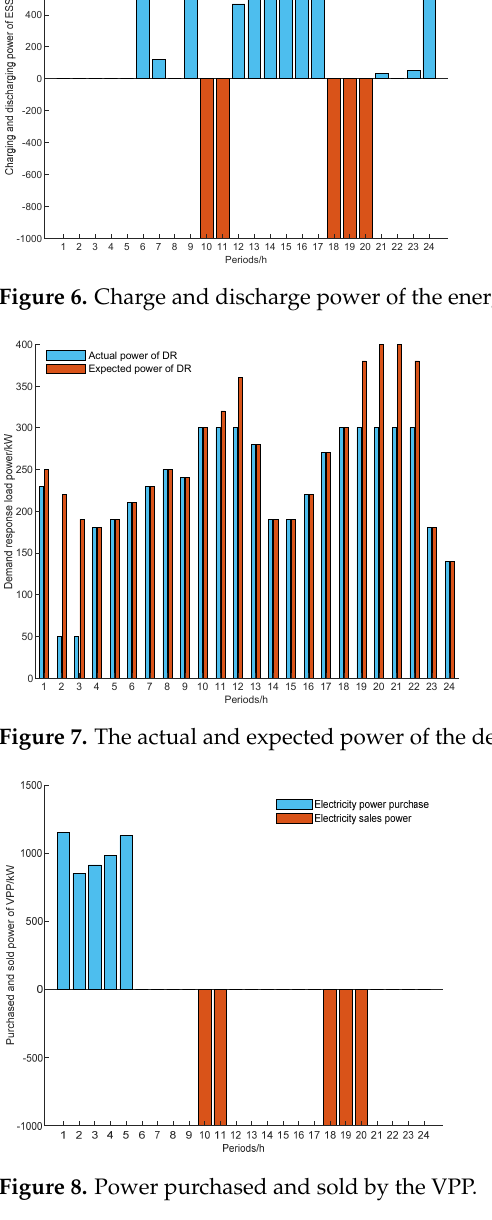
Figure 8. Power purchased and sold by the VPP.